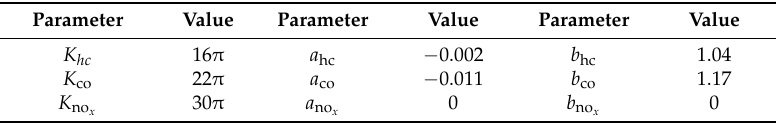
Table 2. Conversion efficiency model